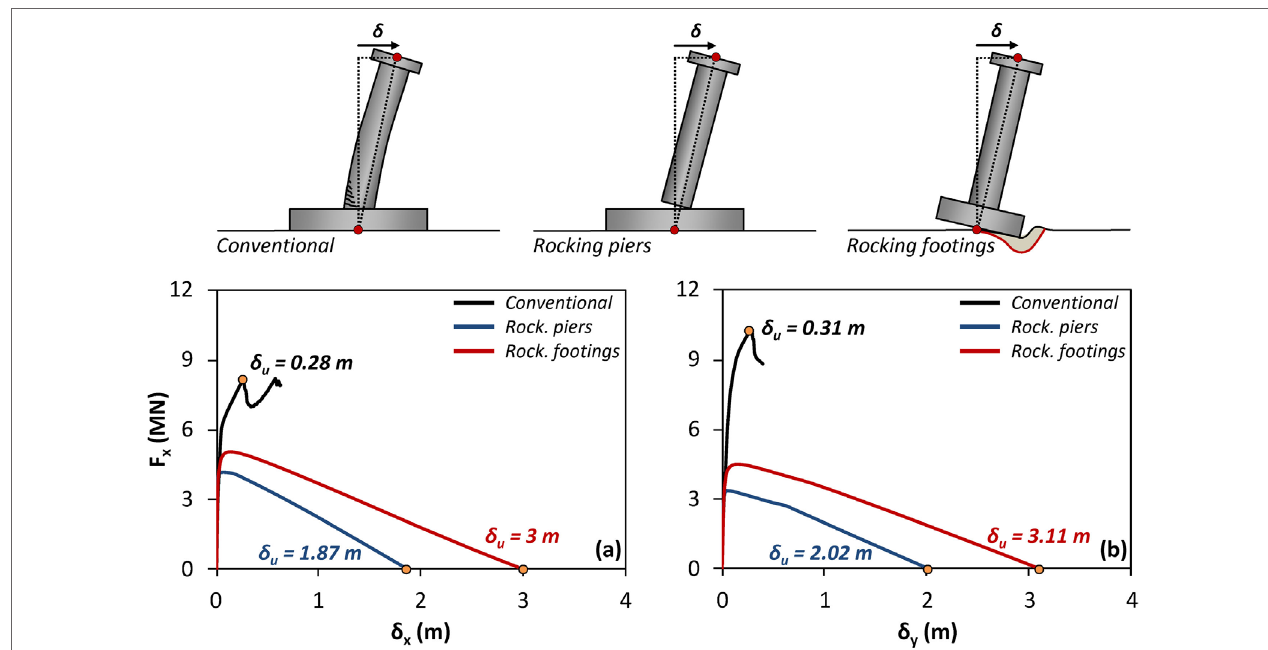
FigUre 5 | Comparison between the examined systems in terms of static pushover total base shear–drift ( F – δ ) response of pier P4 in: (a) the longitudinal and (B) the transverse